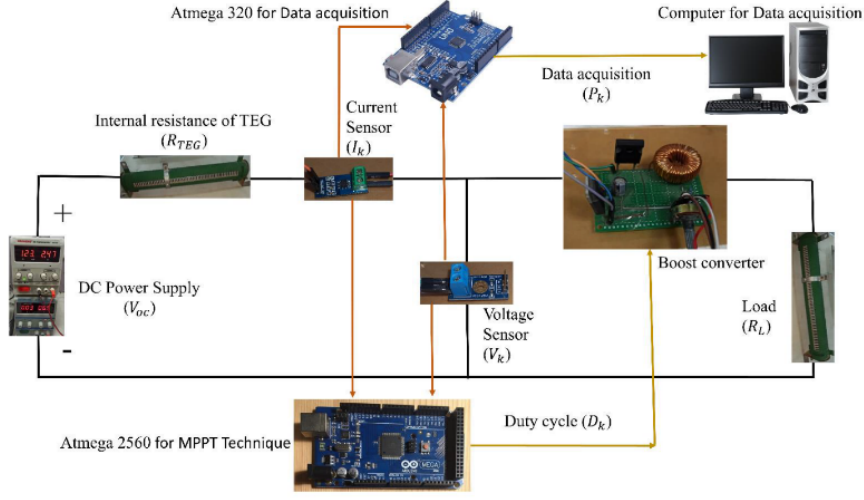
Figure 19. An experimental setup with a low ‐ cost PV emulator.